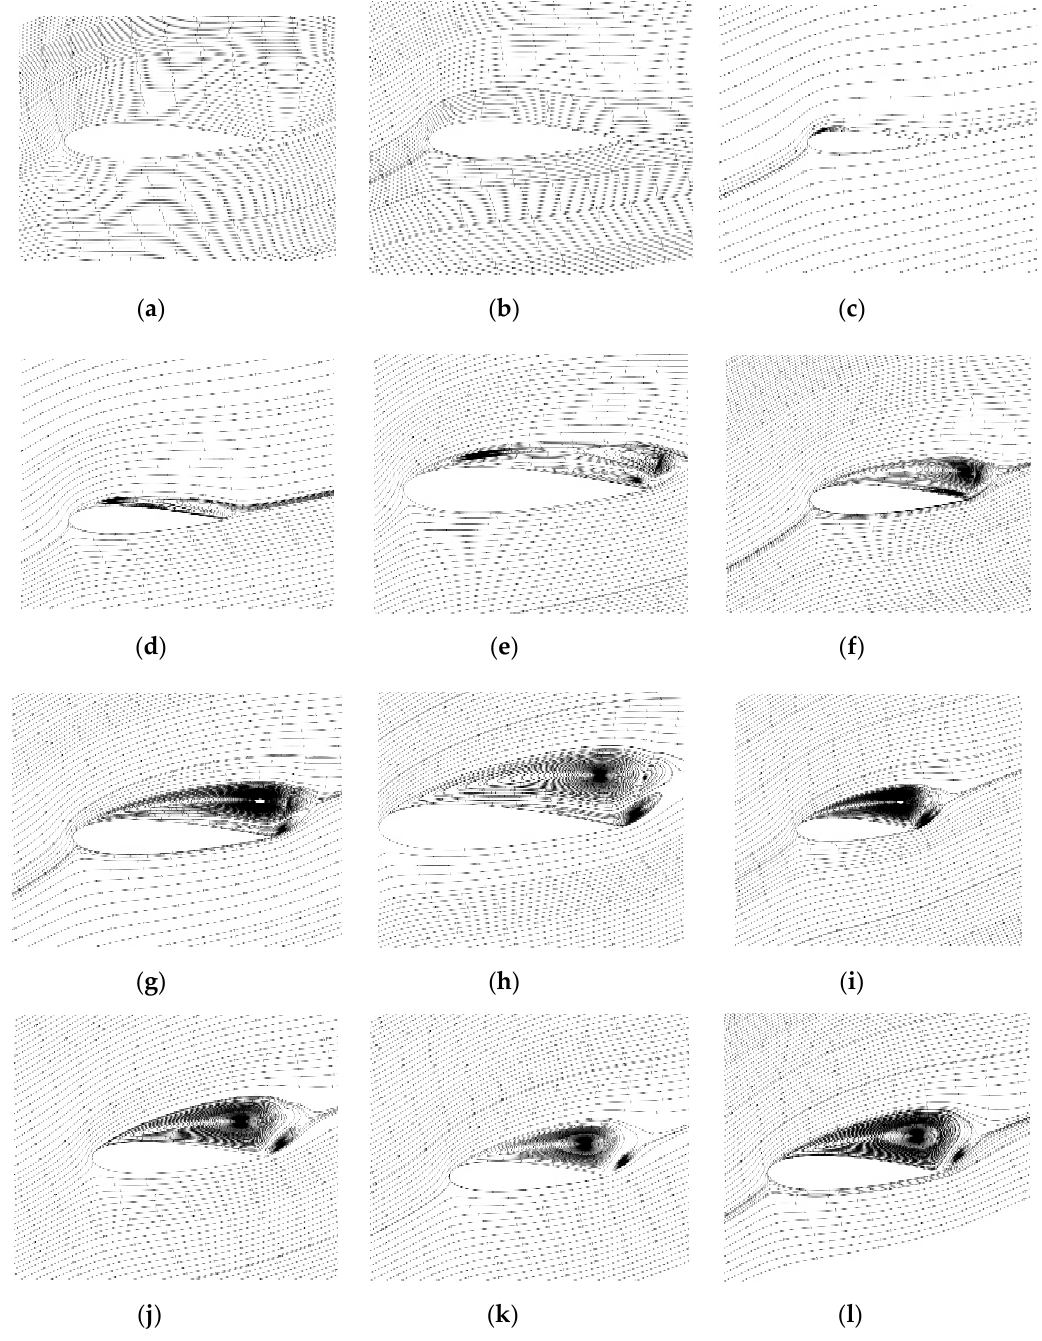
Figure 22. Streamline of standard NACA0012 airfoil at a 14° angle of attack at different times. ( a ) t = 0.001 s, ( b ) t = 0.01 s, ( c ) t = 0.02 s, ( d ) t = 0.03 s, ( e ) t = 0.04 s, ( f ) t = 0.05 s, ( g ) t = 0.06 s, ( h ) t = 0.07 s, ( i ) t = 0.09 s, ( j ) t = 0.11 s, ( k ) t = 0.13 s, and ( l ) t = 0.15 s.